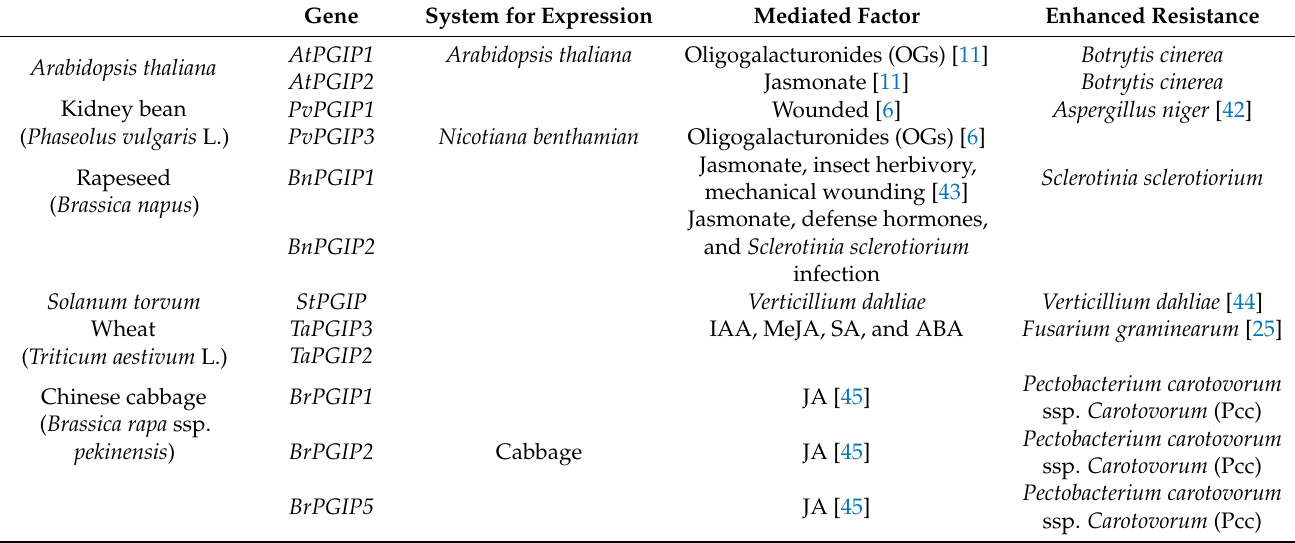
Table 1. PGIP regulatory factors tested in different systems against